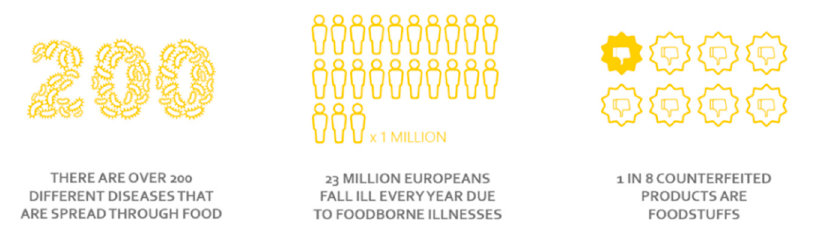
Figure 2. Concerns about food quality and food safety (source, AIP in relation to food safety [17]).